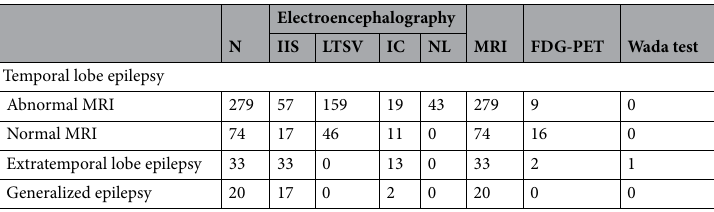
Table 2. Modality used for the presurgical evaluation in the second period. IIS Interictal scalp, LTSV Long-term scalp video, IC Intracranial, NL No lateralization, MRI Magnetic resonance imaging, FDG-PET fFluorodeoxyglucose-positron emission